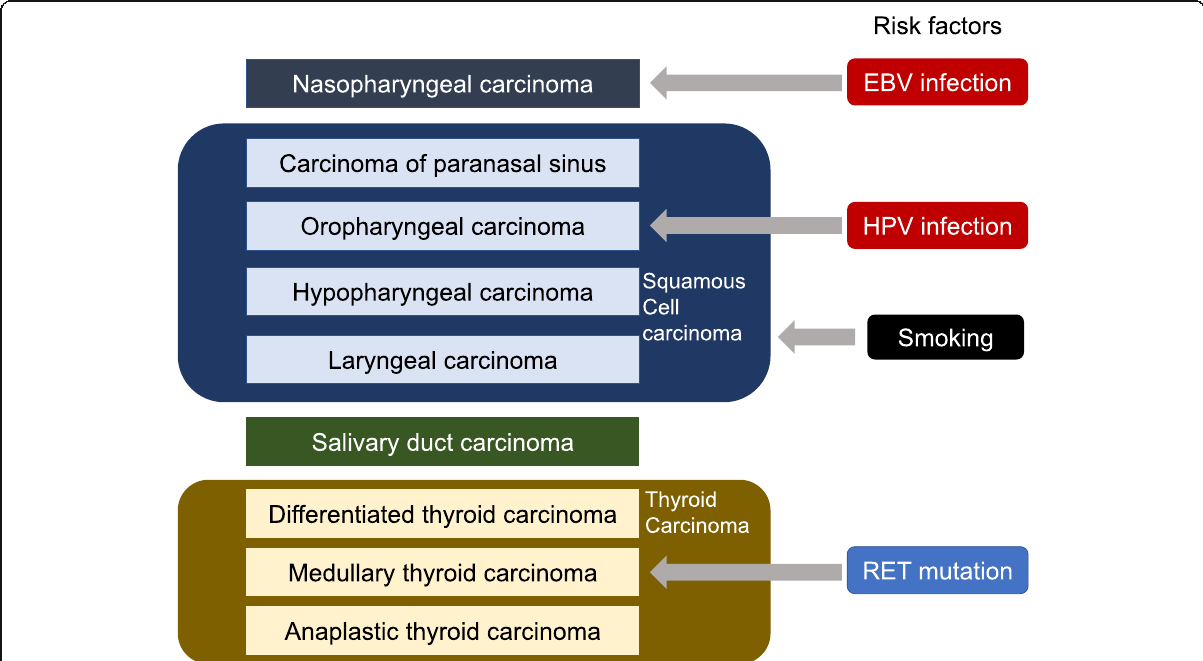
Fig. 1 The Variety and risk factors of head and neck cancers. Smoking is the most facous risk factor for Squamous cell carcinoma of the head and neck (SCCHN), and viral infections such as human papilloma virus (HPV) and Epstein-Barr virus (EBV) are known to be risk factors for specific head and neck cancers. In thyroid cancers, RET mutation is known to have a close relationship with medullary thyroid carcinoma